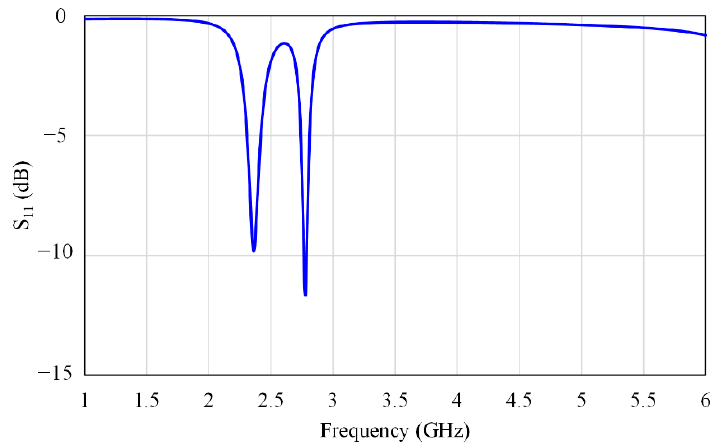
Figure 11. Simulated S 11 for slotted patch antenna.